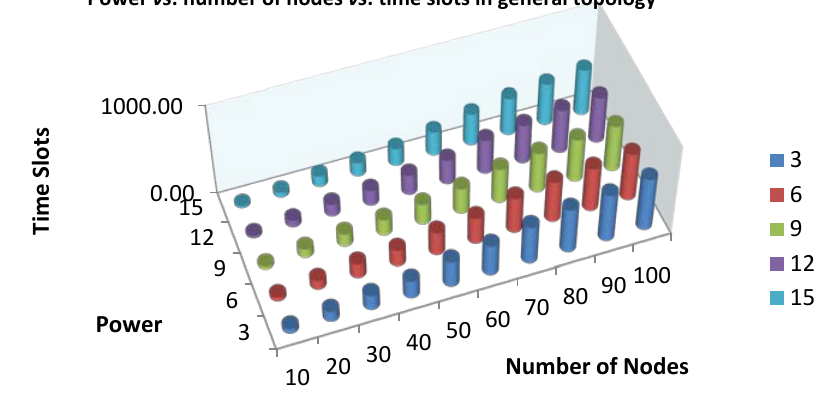
Figure 9. Power vs. number of nodes vs. time slots in the general